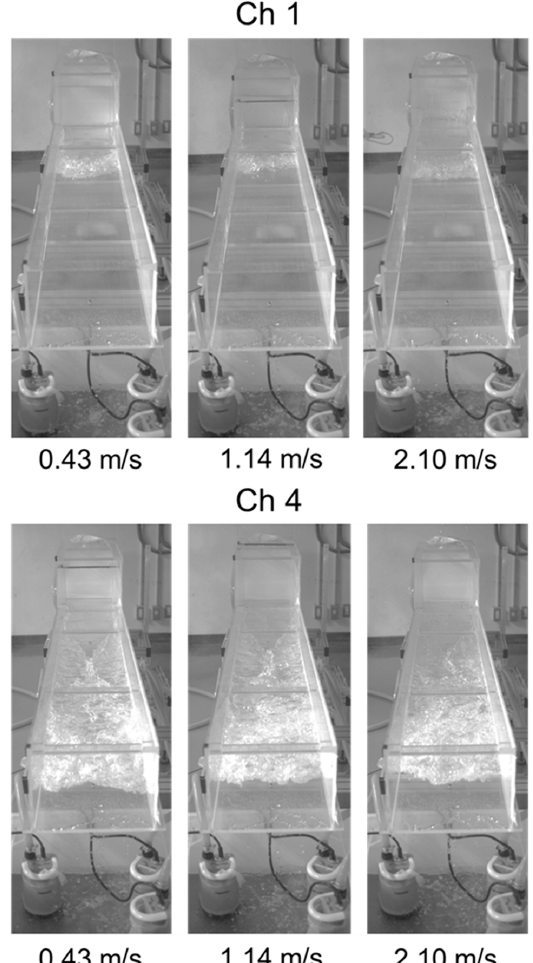
Figure 9. Snapshots of three different dam-break experiment trials taken from the downstream end of the flume. Upper and lower panels show the flow when it reached Ch1 and Ch4, respec- tively. The three gate speeds considered were: slow (0.43 m/s), medium (1.14 m/s), and fast (2.10